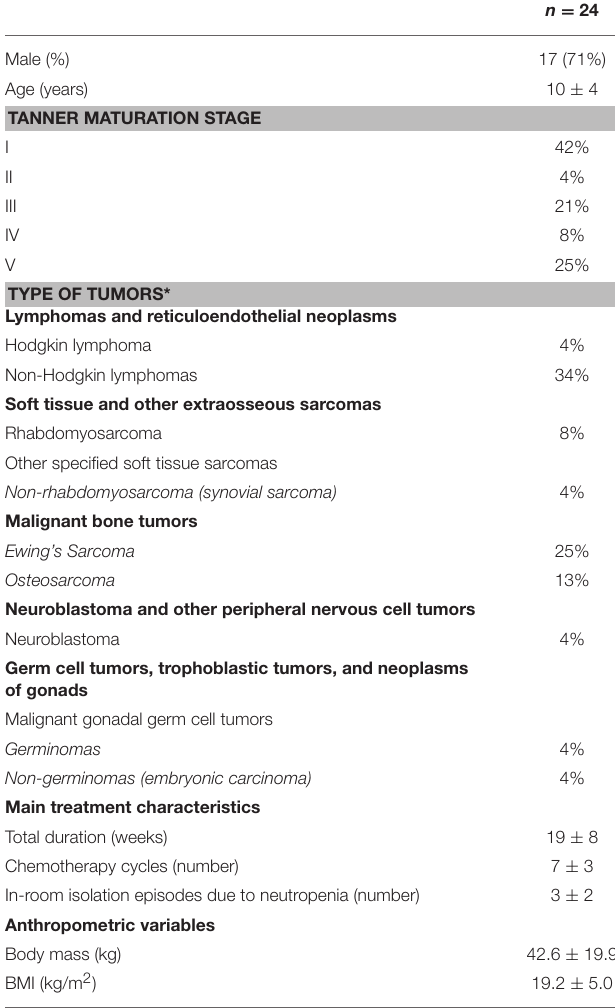
TABLE 1 | Main demographic and clinical characteristics of the study participants at baseline (i.e., upon